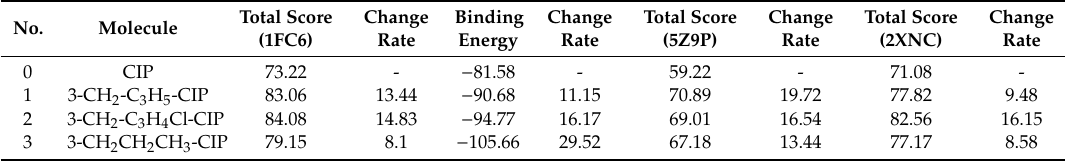
Table 9. The molecular docking score of the CIP